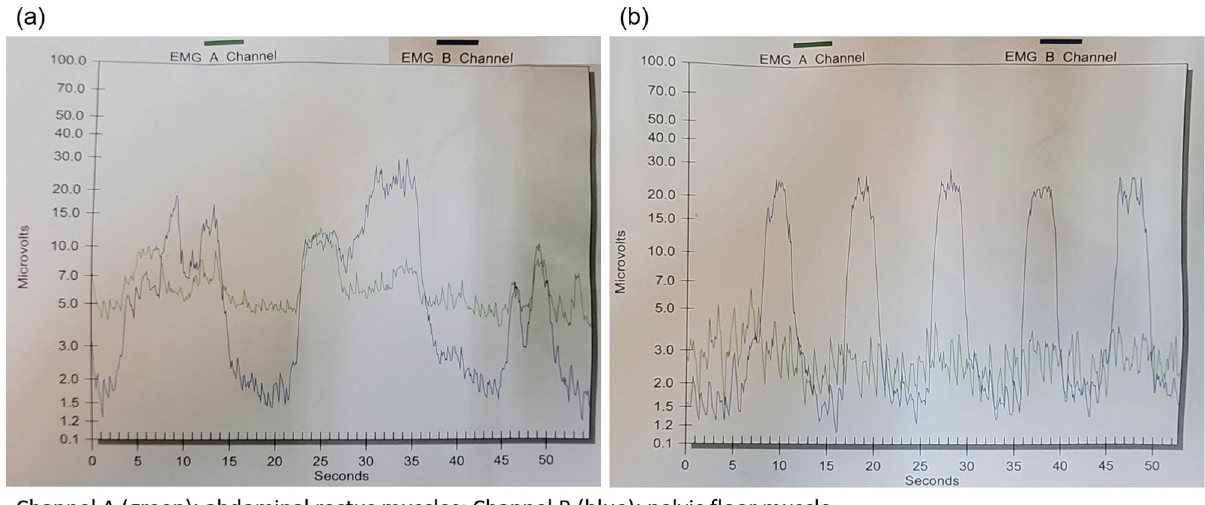
Figure 3. The example of electromyography on ( a ) inadequate PFM isolation, contraction and poor relaxation at the first time of office visiting; ( b ) An adequate picture of EMG which indicated well PFM isolation and relaxation after biofeedback PFMT at the 6th time of office